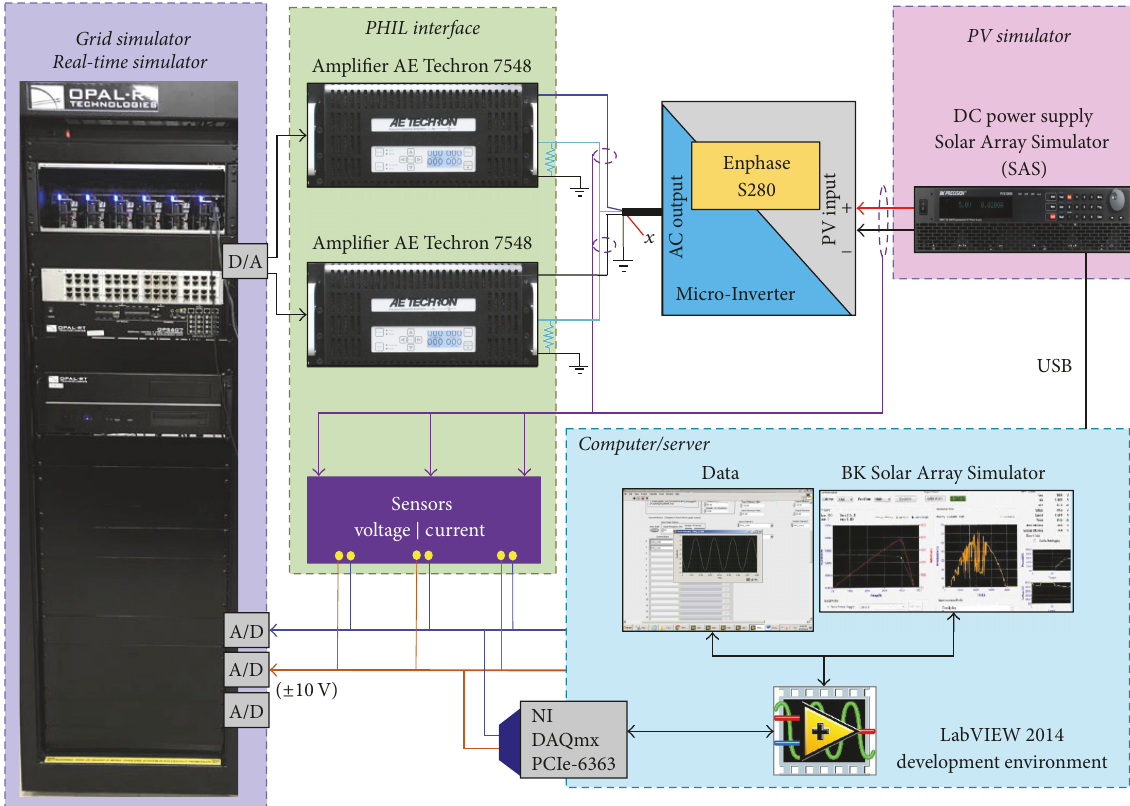
Figure 11: Laboratory setup for PHIL testing of the Enphase S280 microinverter.